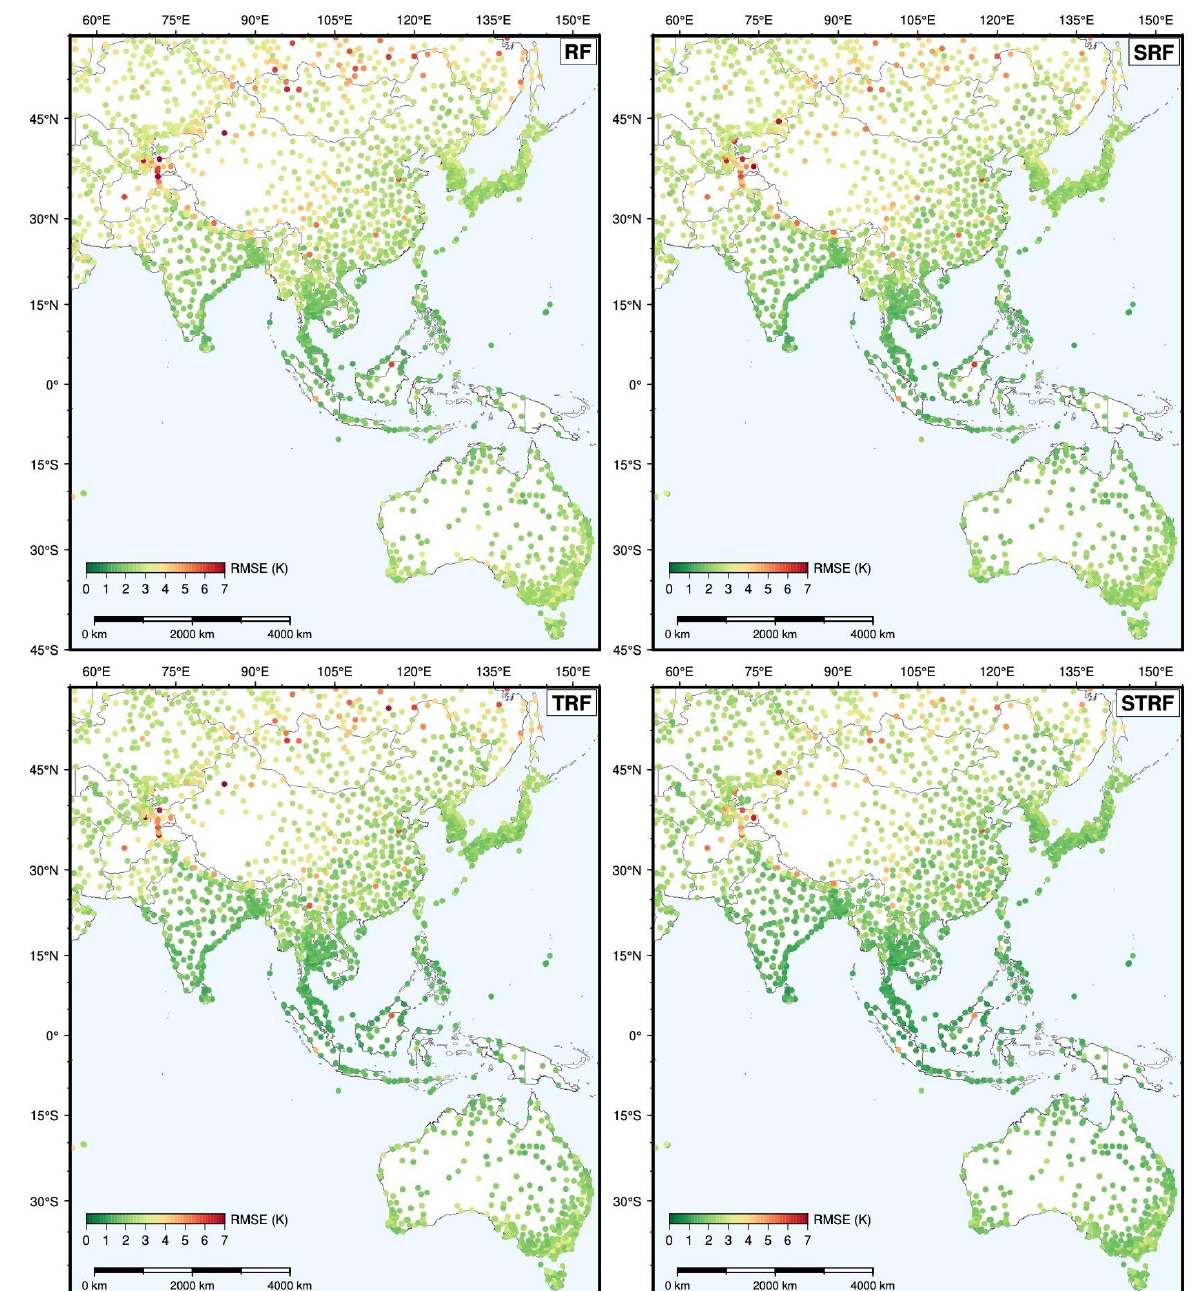
Figure 7. Spatial distribution of site-specific mean RMSE across the study area for the four hourly estimation models using site-based